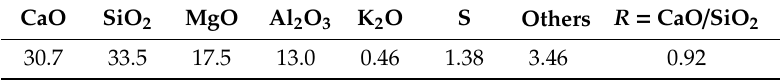
Table 2. Composition of the blast-furnace (BF) slag of a European steel company (%).